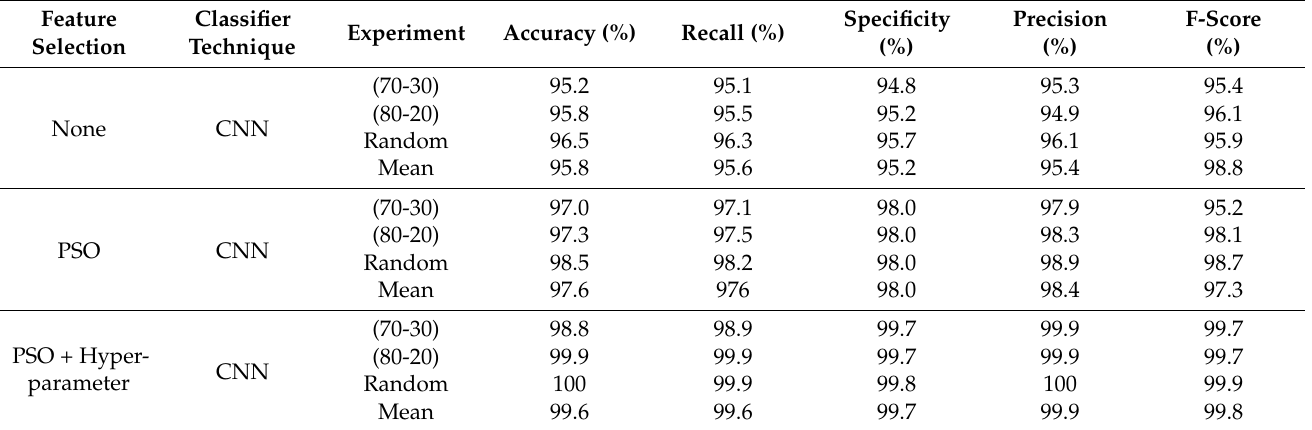
Table 3. the performance comparison results in the leukemia